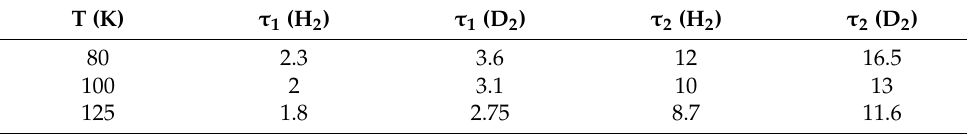
Table 1. τ 2 and τ 2 intra-cage site-hop relaxation times in picoseconds.